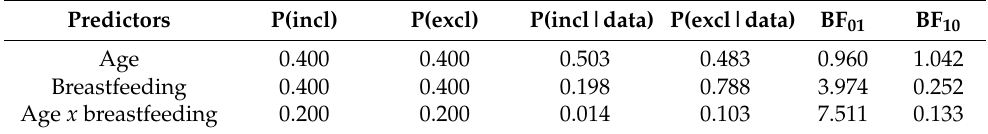
Table 2. Analysis of the effects in the Bayesian ANOVA conducted on maternal years of formal education.